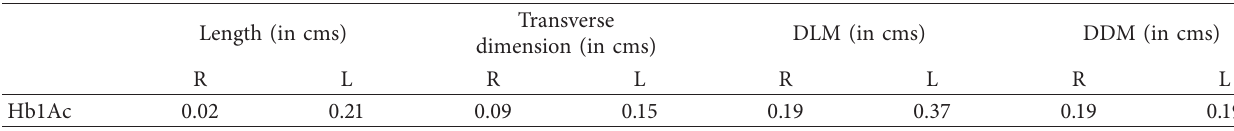
Table 4: Comparison of ultrasonographic measurements of parotid glands in study subjects (type 2 diabetes mellitus) with insulin use (oral hypoglycemic drugs and insulin) and those only with oral hypoglycemic drugs.